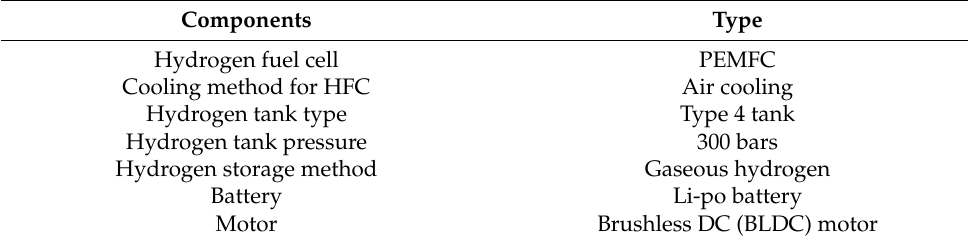
Table 3. Propulsion system configuration for the HFC eVTOL